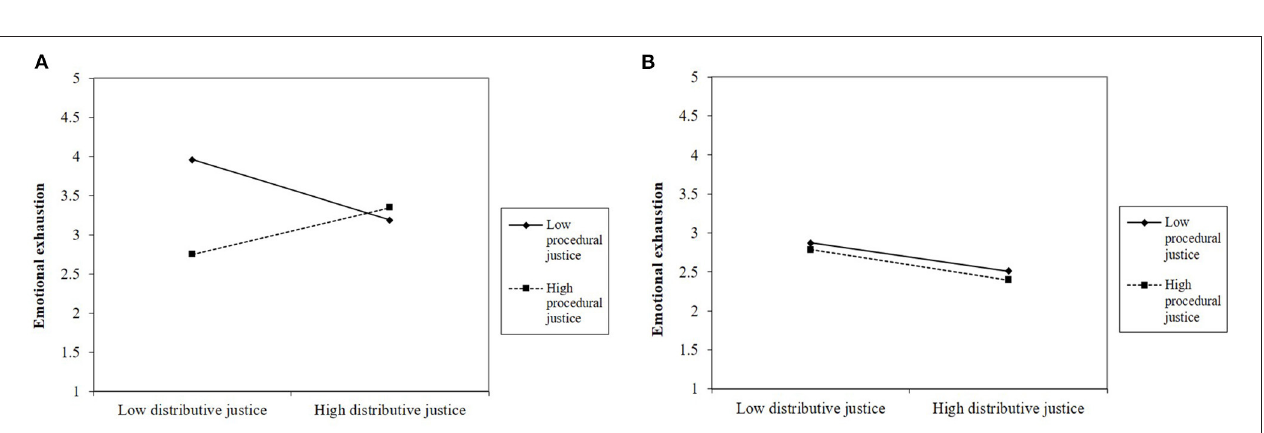
FIGURE 2 | (A) The effect of distributive and procedural justice on emotional exhaustion when job autonomy is low (Study 1). (B) The effect of distributive and procedural justice on emotional exhaustion when job autonomy is high (Study 1).